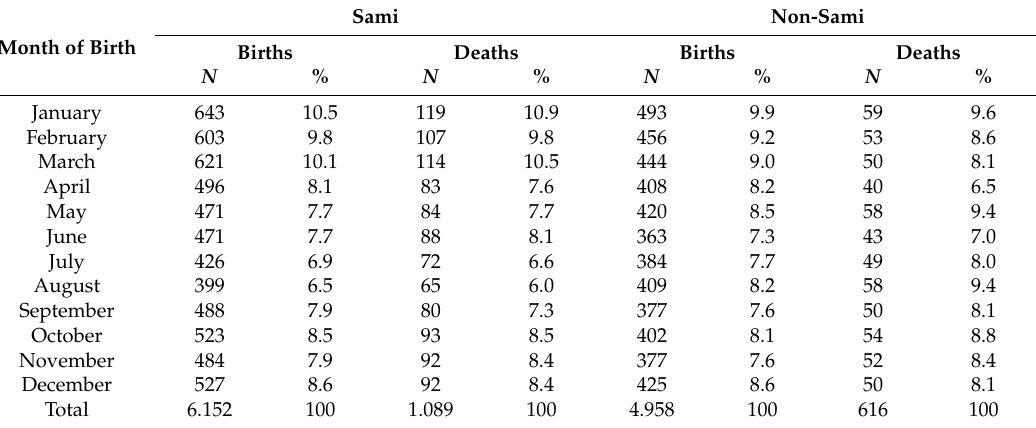
1 Source: Demographic Data Base, Umeå